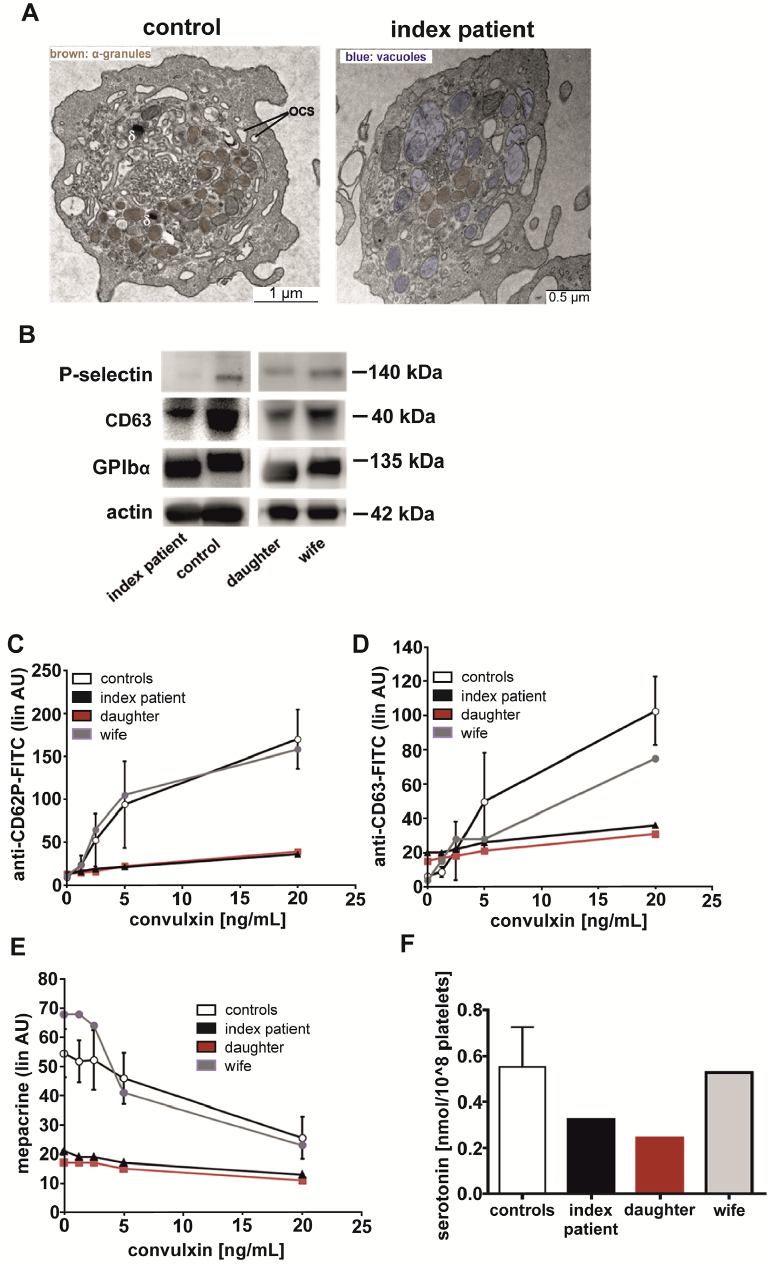
Figure 4. Platelet α - and δ -granule analysis of the GATA1-T296P-variant-affected index patient, his daughter, and his unaffected wife. ( A ) Transmission electron images of platelets from the index patient and his wife as day control. α -granules are colored in brown, δ -granules are indicated as δ ; OCS: surface-connected or open canalicular system, where vacuole compartments are colored in blue. ( B ) Immunoblotting analysis of P-selectin (CD62P), CD63, and GPIbα in lysates of washed platelets from the index patient, his daughter, his wife, and an additional day control. Actin labeling served as protein loading control. ( C , D ) Flow cytometric analysis of ( C ) P-selectin/CD62P and ( D ) CD63 platelet surface expression in response to the GPVI-agonist convulxin of the index patient, his daughter, his wife, and additional controls ( n = 30). ( E ) Flow cytometric analysis of mepacrine uptake in platelet δ -granules (convulxin 0 µ g/mL) and convulxin-induced release convulxin of the index patient, his daughter, his wife, and additional controls ( n = 30). ( F ) Quantification of serotonin in lysates of washed platelets from the index patient, his daughter, his wife, and additional controls ( n = 10) by using an ELISA